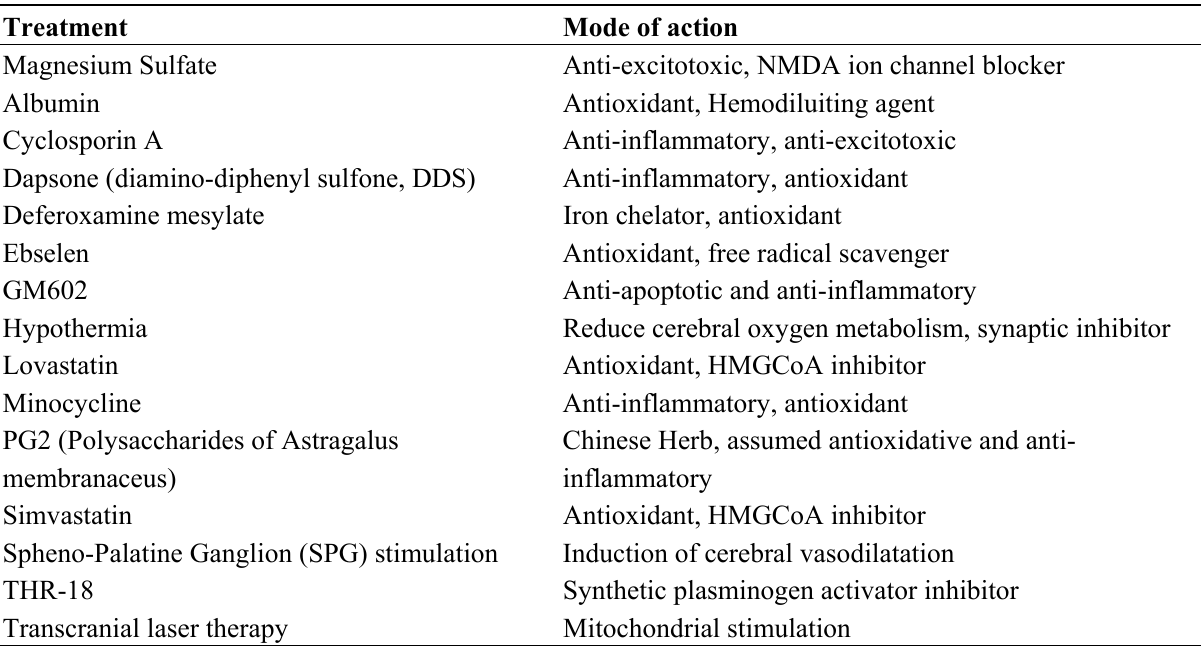
Table 1. Neuroprotective treatments currently investigated in phase II and phase III clinical trials.